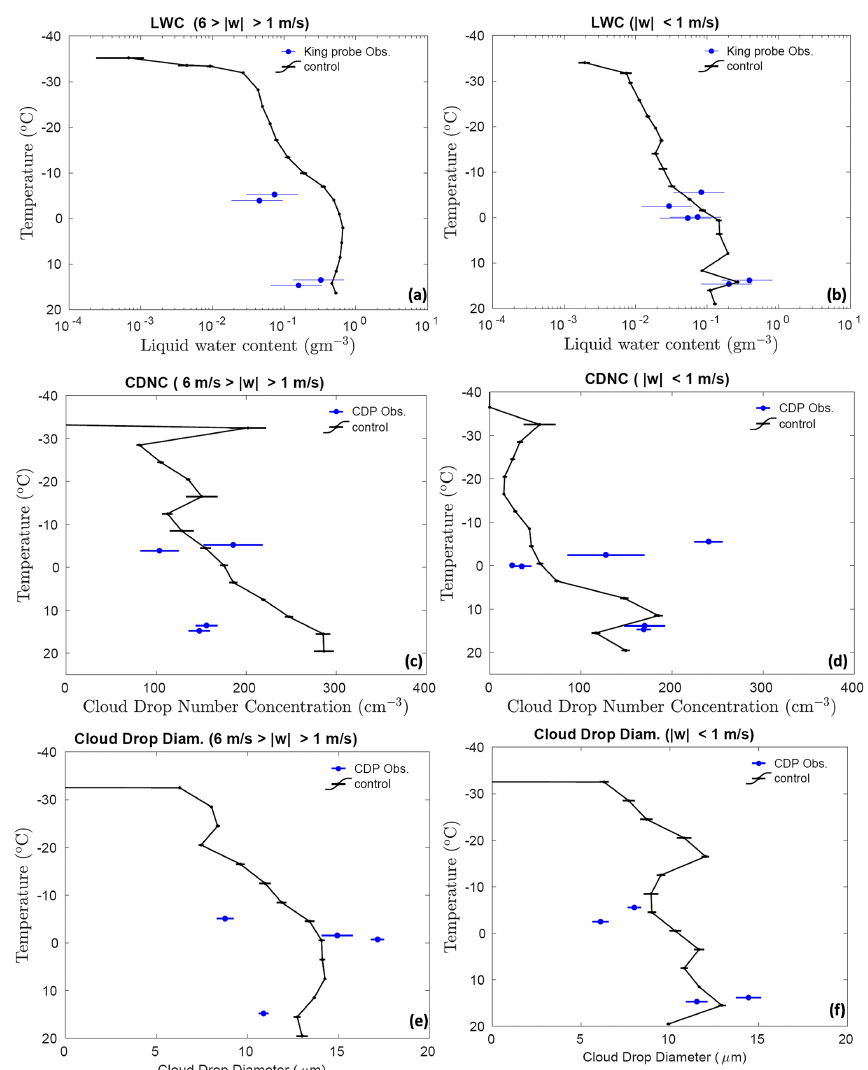
Figure 2. Comparison of the control simulations by AC with aircraft observations for the liquid water content conditionally averaged over (a) convective (6 ms − 1 > | w | > 1ms − 1 ) and (b) stratiform ( | w | < 1ms − 1 ) regions, cloud drop number concentration over (c) convective and (d) stratiform regions, and average size of cloud droplets ( < 20µm) conditionally averaged over (e) convective and (f) stratiform regions. All the vertical profiles shown here are averaged for the whole domain. The error bars were estimated based on five ensemble